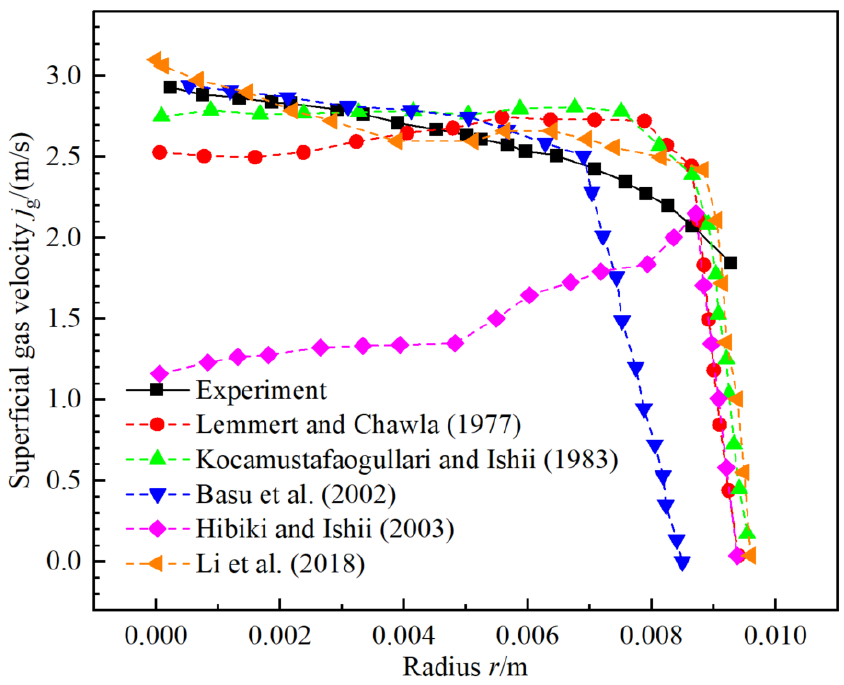
Figure 7. Superficial gas velocity j g distribution of various typical models of N n with model of D d [8], f [46], a ( d i , d j ) [57], Ω ( V p ), β ( f bv , 1) [54] and DEBORA-1 experiment ( P = 2.62 MPa) [28] at z =